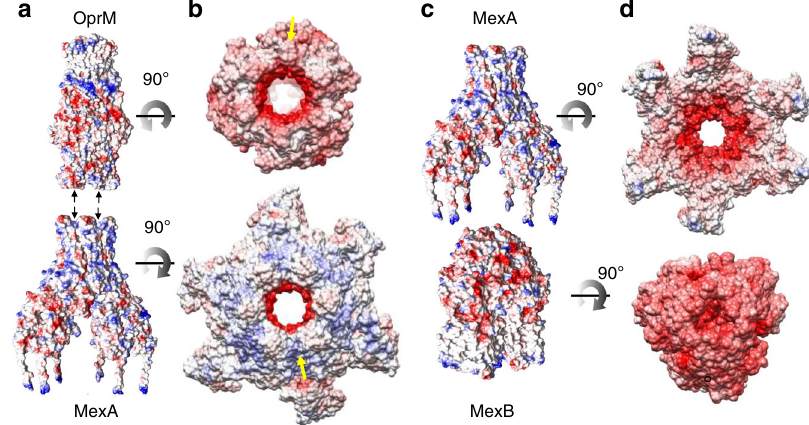
Fig. 4 Coulomb and electrostatic potential surfaces at the OprM-MexA and MexA-MexB interfaces. a Side views of OprM and MexA Coulomb potential surfaces. b Electrostatic potential surfaces depicting contacts between OprM and MexA (90° rotation with respect to orientation in a ) with a strong complementarity of potential surfaces, negative charges of OprM facing the positive charges of MexA and vice versa as illustrated with yellow arrows. This surface complementarity is indicative of strong energy binding of tip to tip interaction between OprM and MexA. c Side views of MexA and MexB Coulomb potential surfaces. d Electrostatic potential surfaces depicting contacts between MexB and MexA (90° rotation with respect to orientation in c ). No complementary potential is observed indicative of reduced energy binding which is in favor of alternate conformational changes for drug extrusion cycle. Electrostatic potential surfaces were generated by using Amber ff14SB force fi eld ( ε in =